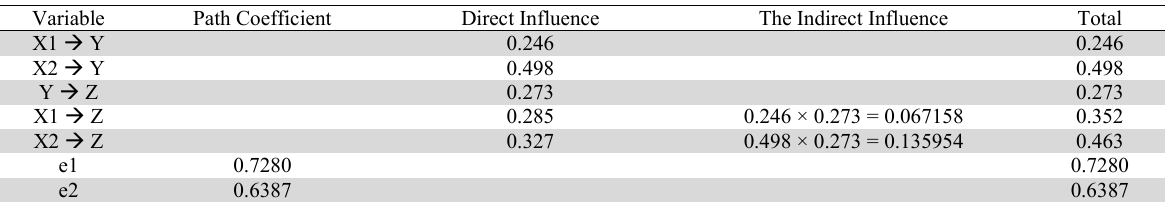
Direct and Indirect Influence